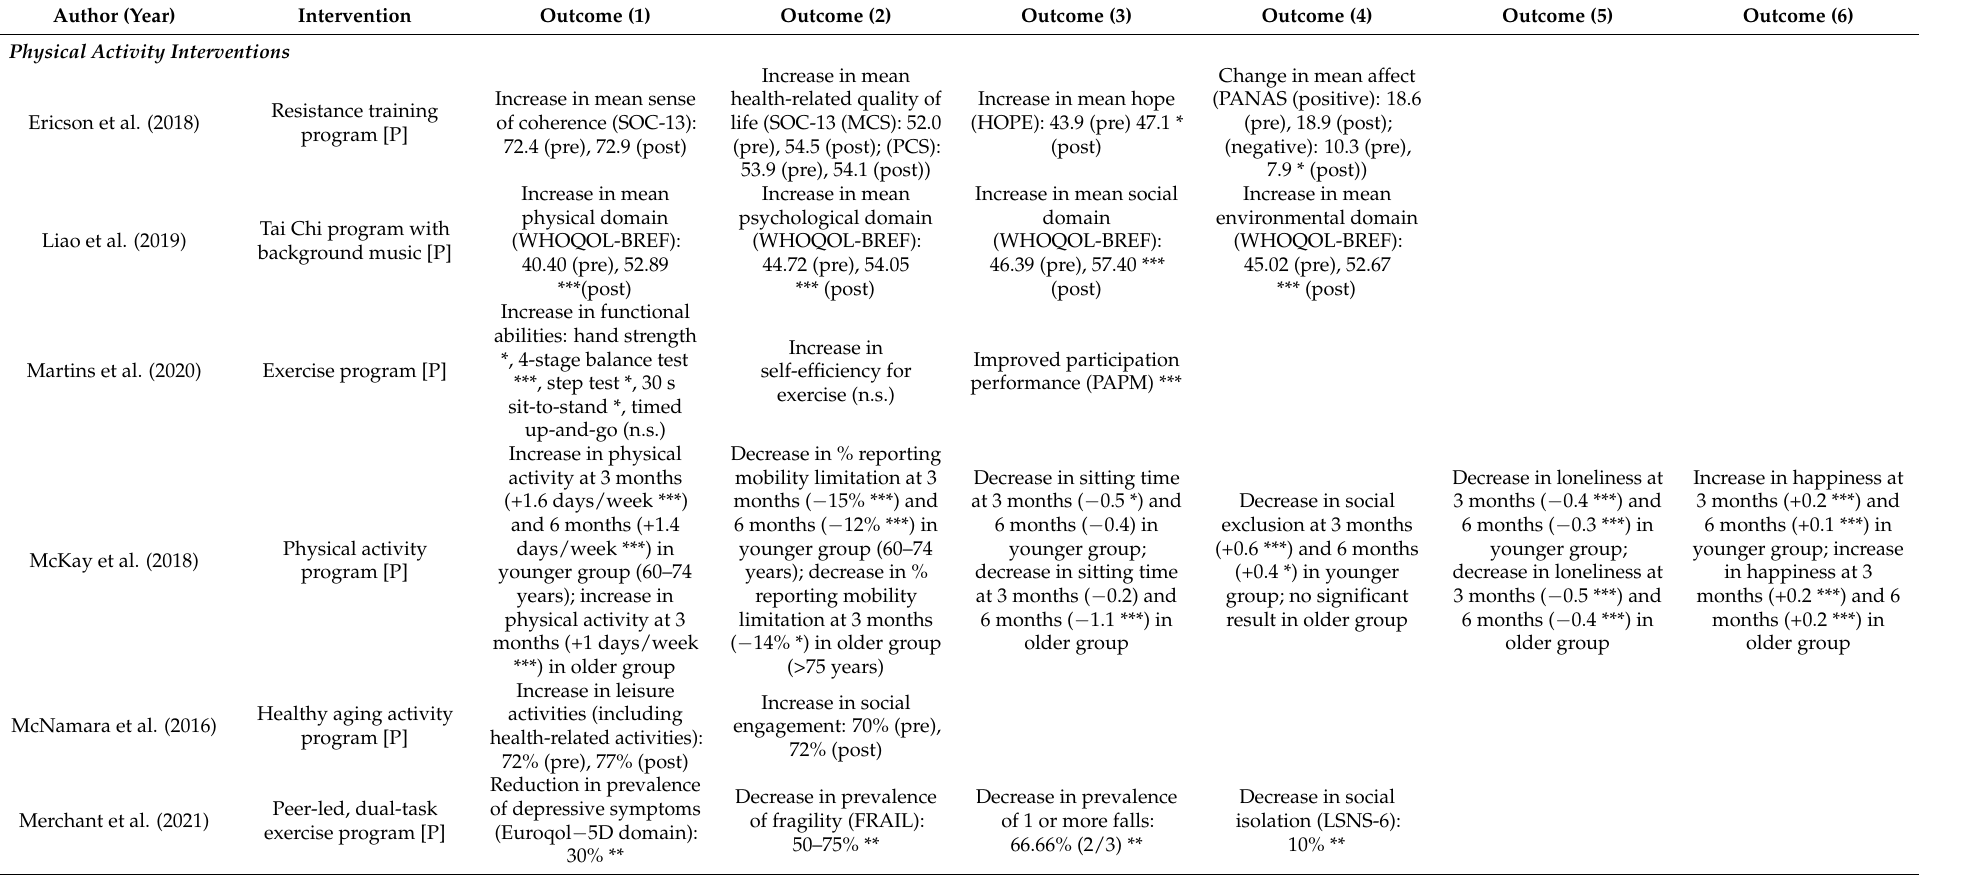
Table A2. Health and social outcomes of quantitative